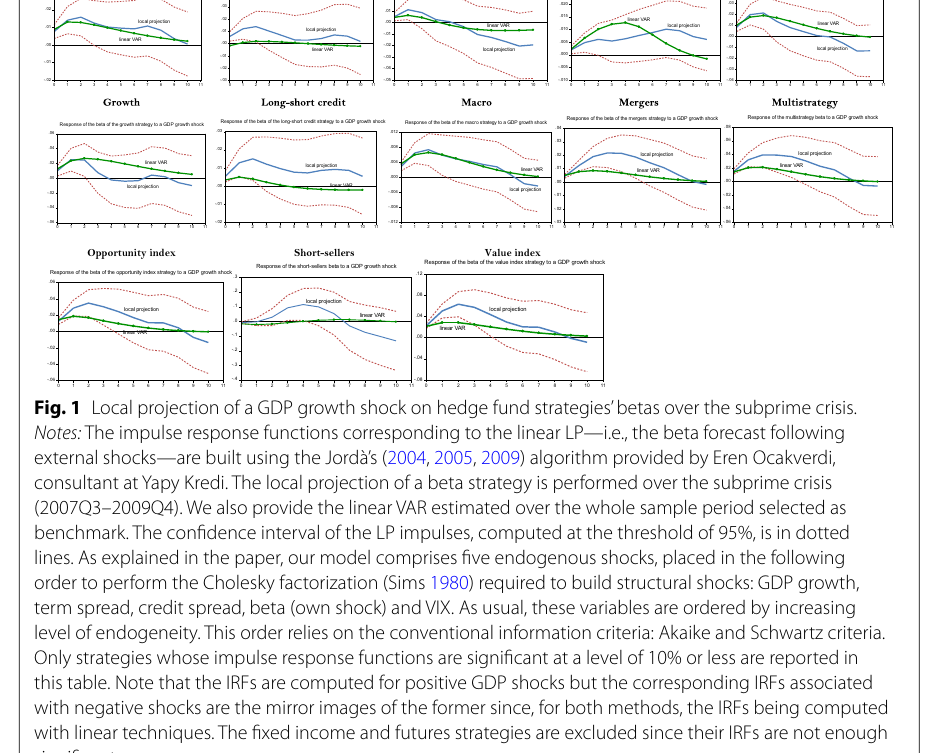
significant asymmetries because the plots associated with LP and the benchmark VAR are similar. Hence, the decrease in the beta of the general index during the crisis after a negative GDP shock is close to its average response over the entire sample period.